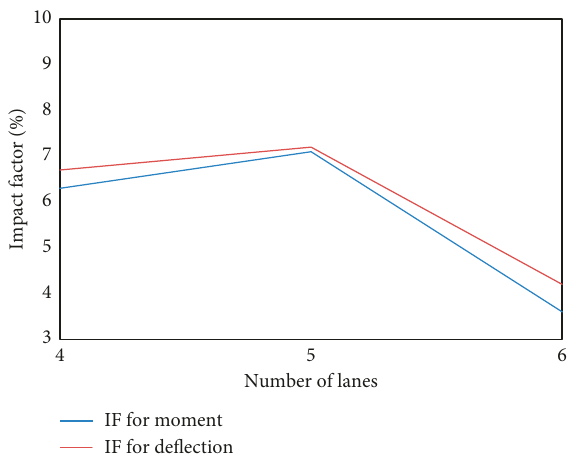
Figure 7: Effect of number of lane loads on the dynamic impact